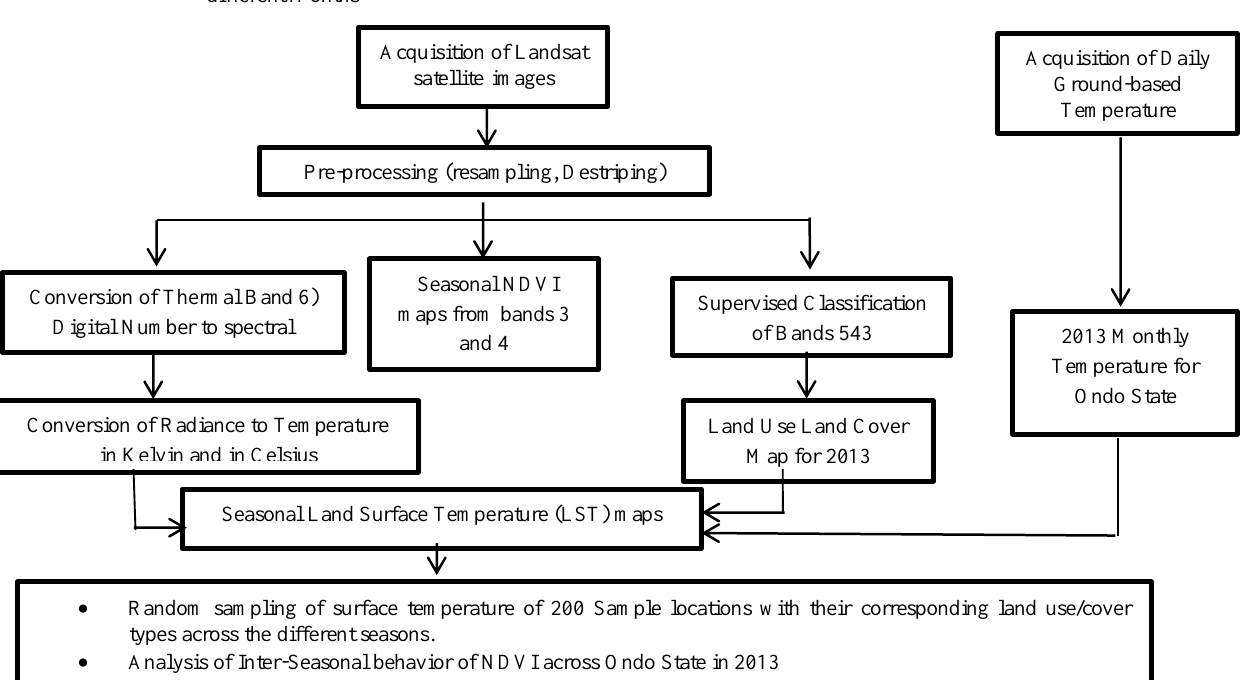
Figure 5: Methodology Framework for the